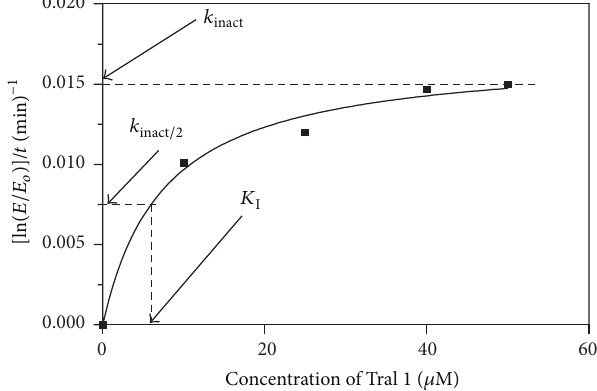
Figure 5: The rate of loss of GST 𝜀 2 activity with increase in Tral 1 concentration after 30 min incubation. This graph was obtained by analysing data according to the method of Maurer and Fung [11] so is the concentration as to determine the inactivation parameters. 𝐾 I of inhibitor which gives half the maximal rate of